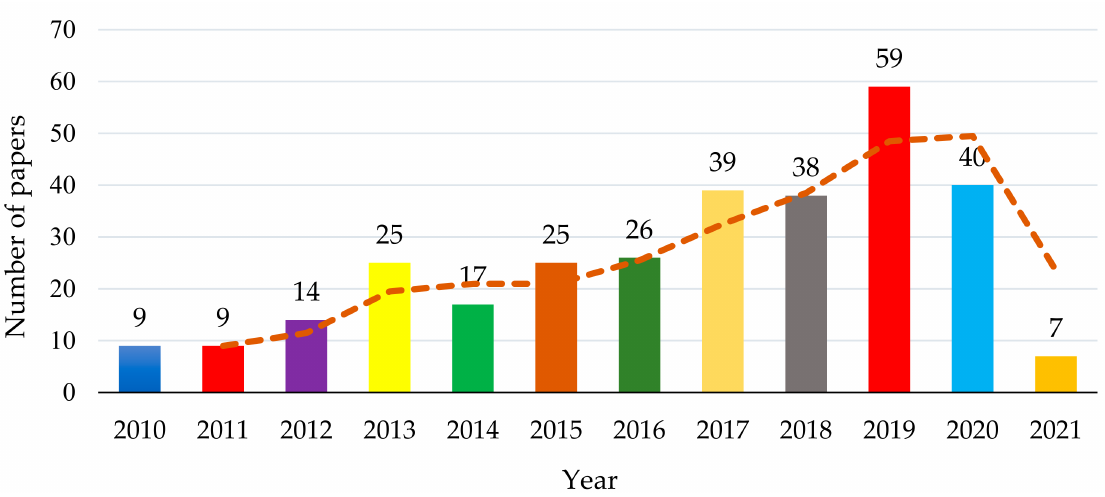
Figure 3. The number of papers published (2010–2021) before scanning